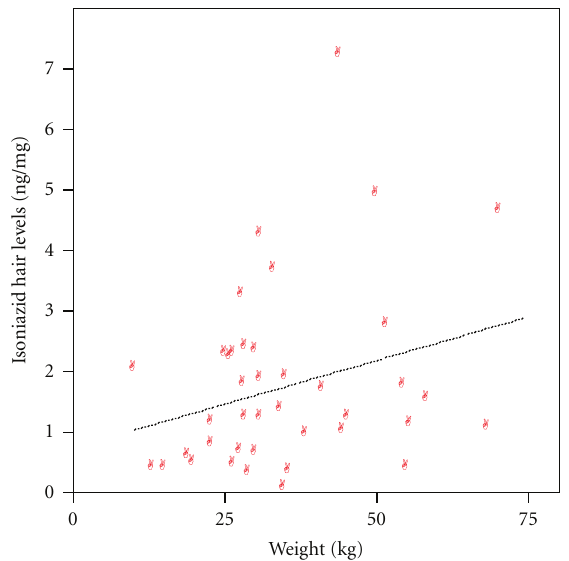
Figure 5: Acetylator phenotype represented as acetylisoniazid/iso- niazid ratio (AcINH/INH ratio) and arylamine N-acetyltransferase 2 genotype ( n =